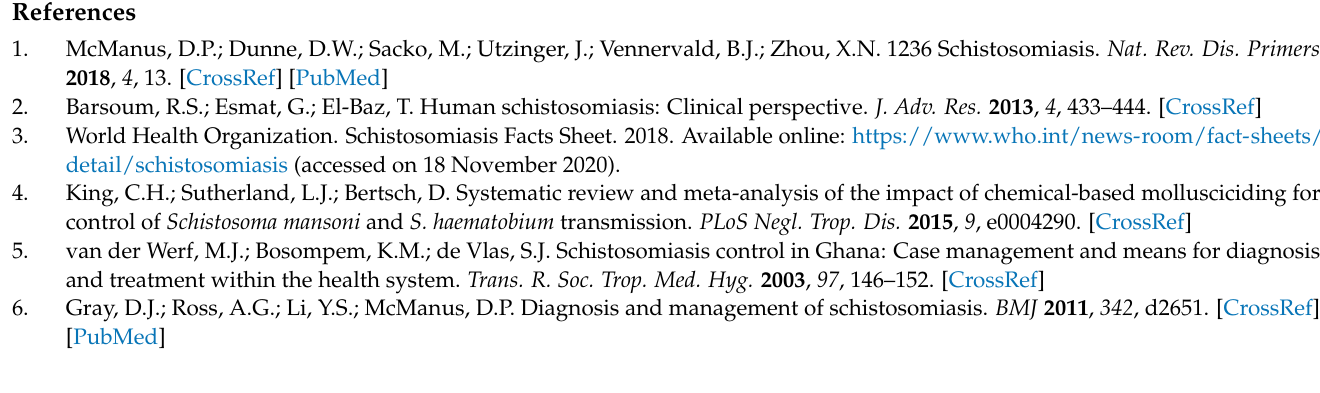
Supplementary Materials: Table S1: Summary of re-docking and crossed-docking rmsd between the atomic coordinates of the co-crystalized ligands pose and the docked pose based on the different sm HDAC8 crystalized proteins used in this study. Table S2: Summary of generated moldels. (Terms are described after the table). Table S3: summary of prediction results based on Models 95 and